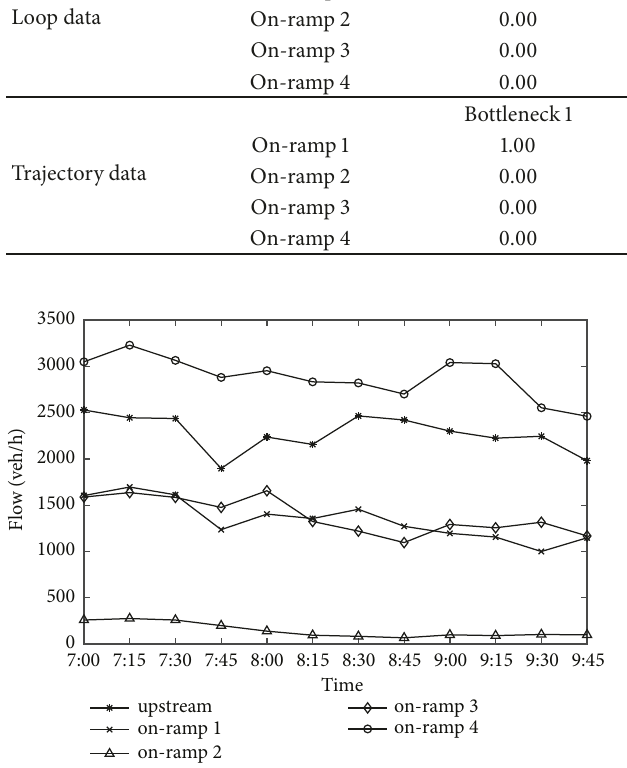
Figure 7: Traffic demand patterns of the test